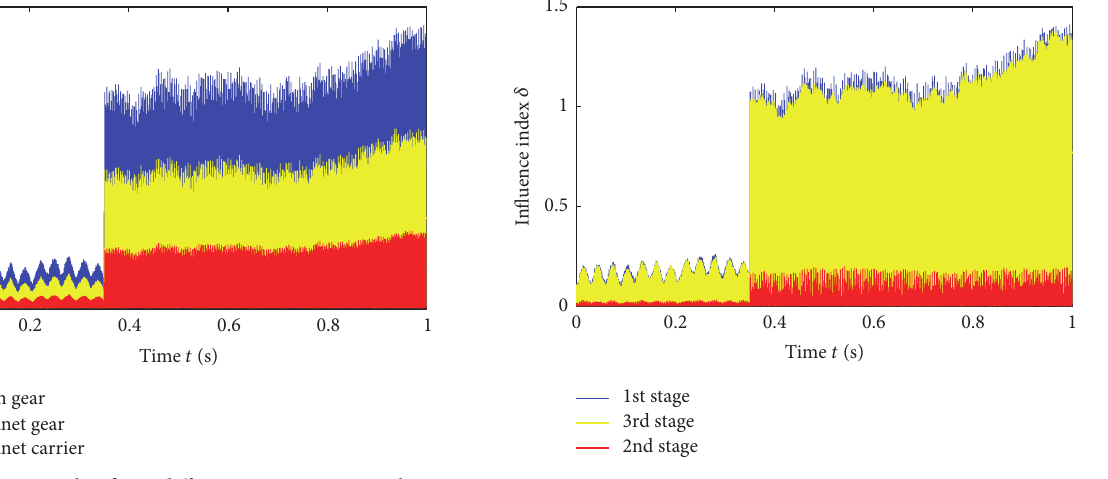
Figure 15: Influence index 𝛿 on sun gear in different